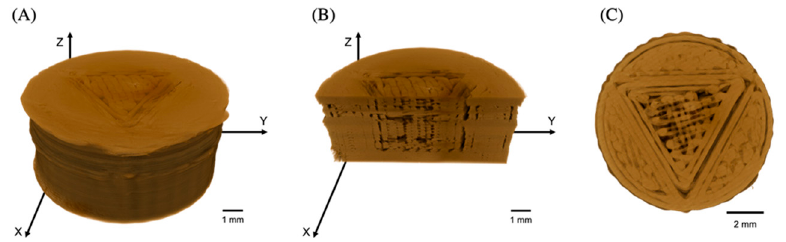
Figure 7. SRXTM images of FDP-loaded 3D-printed tablets with a triangle inner compartment (double the tablet volume, T2X), showing ( A ) the entire tablet, ( B ) a vertical cross-section, and ( C ) a horizontal cross ‐ section of the tablet.